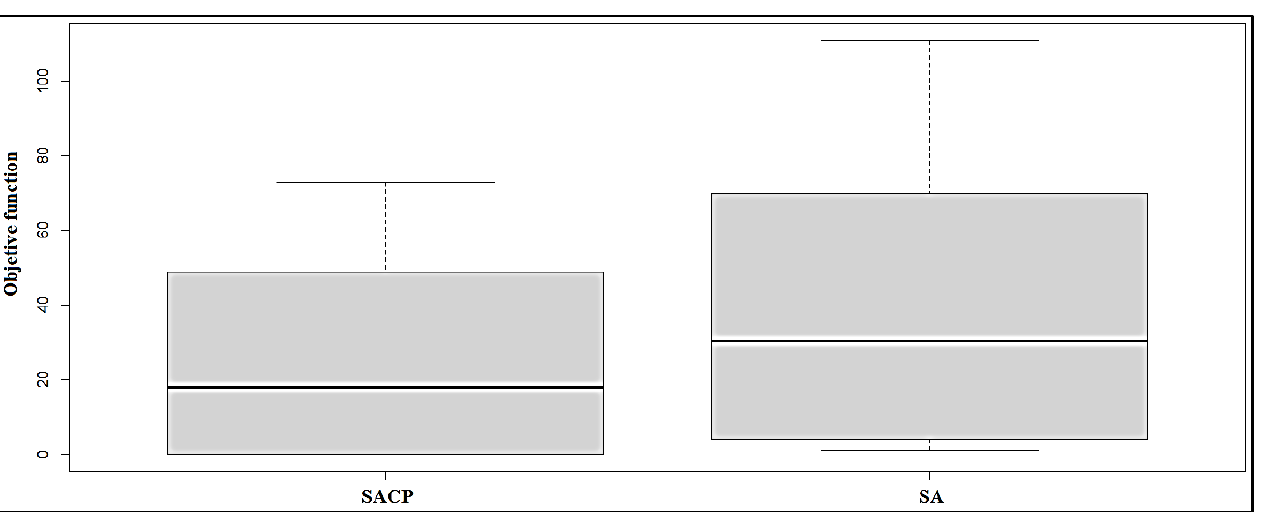
25 of 32 Figure 12. Boxplot of the SACP, ACO and GA algorithms.